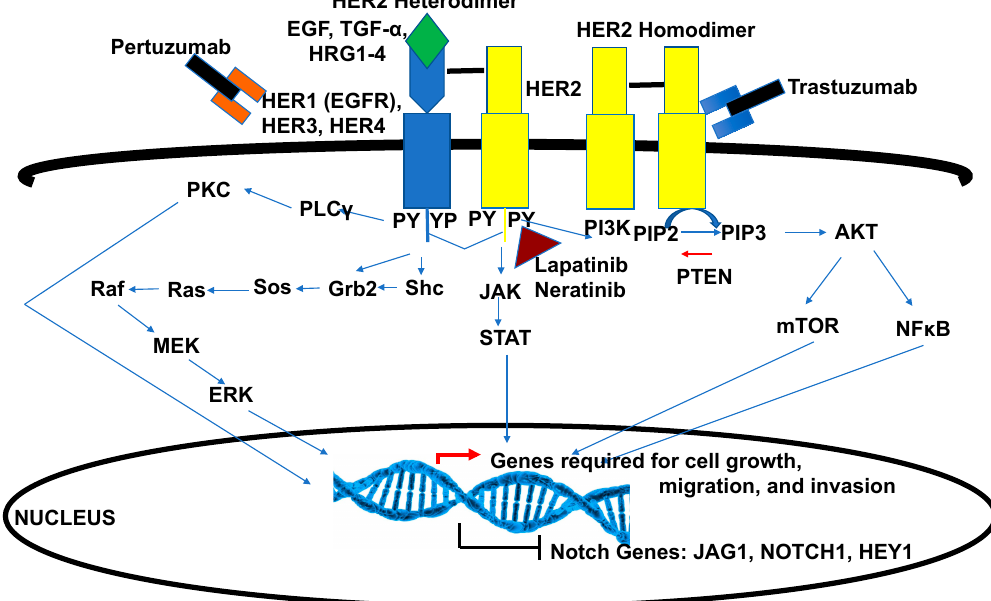
Figure 5. HER2 signaling and regulation of Notch. Gene amplification of the ERBB2 gene results in overproduction of the HER2 protein. High expression of HER2 on the cell surface may promote homodimerization or heterodimerization with HER1, HER3, or HER4. Dimerization results in activation of the HER2 kinase domain and phosphorylation (P) of specific tyrosine (Y) residues within the cytoplasmic tail. The PY residues are docking sites for adaptor proteins including Grb2, Shc, the p85 subunit of PI-3Kinase, and others. HER2 signaling activates many kinase cascades, including the Ras-Raf-MEK-ERK, PKC, JAK-STAT, PI3Kinase-AKT-mTOR, and NF- κ B pathways. Through a diverse transcriptional program, genes are expressed that promote cell-cycle progression, migration, and invasion. Other genes, including NOTCH1, JAG1 , and HEY1 , are repressed. Upon treatment with HER2-targeted therapy, using humanized monoclonal antibodies such as trastuzumab and pertuzumab or a small molecule tyrosine kinase inhibitor (lapatinib or neratinib), Notch genes are de-repressed. High Notch signaling promotes CSC enrichment, resistance, and increased tumor-initiating potential.